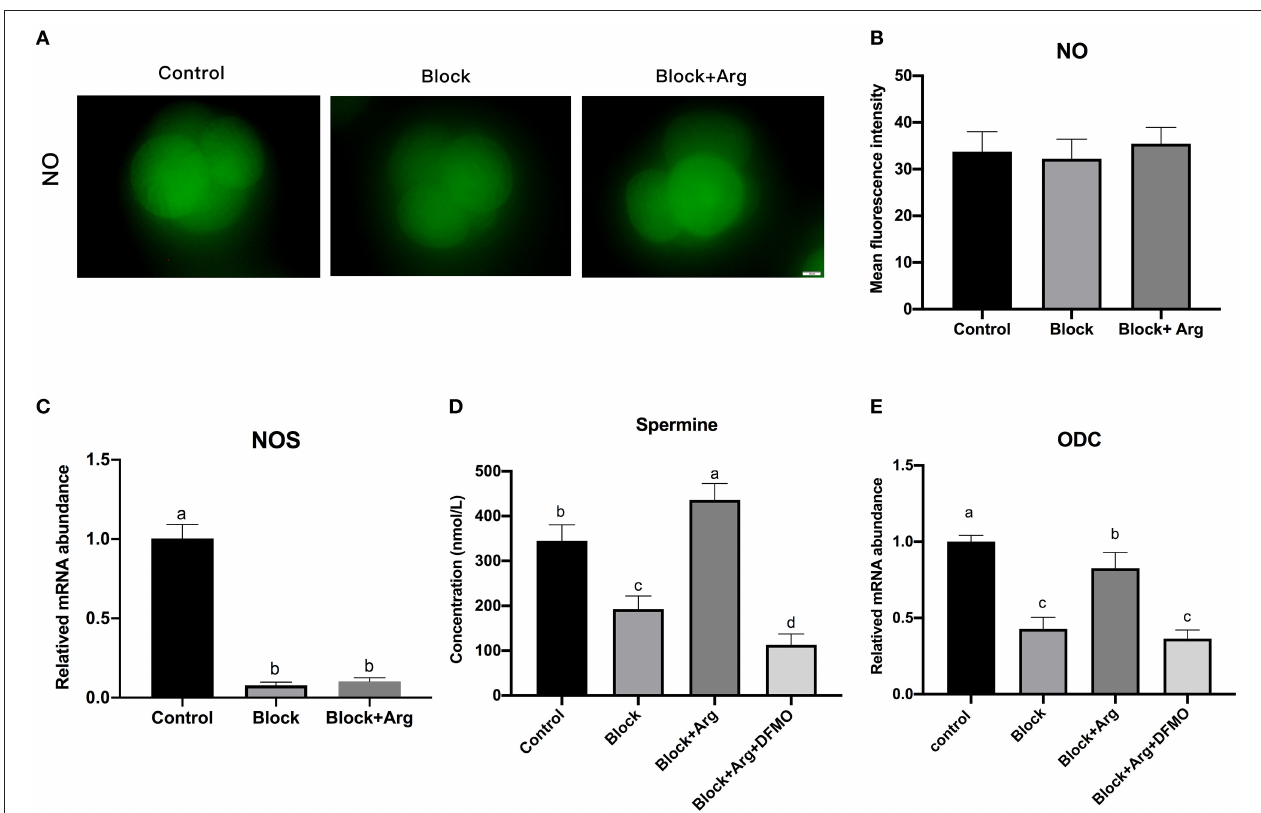
FIGURE 5 | Analysis of the arginine metabolic pathway during ZGA under nutrition restriction. (A) Representative images of DAF-FM fluorescence in the Control, Block and Block + Arg groups. Nitric oxide production viewed by using DAF-FM staining of 4-cell embryos. Bar = 50 µ m. (B) Results of the statistical analysis of embryonic NO intensity in the Control, Block and Block + Arg groups. Control: n = 30; Block: n = 30; Block + Arg: n = 30. (C) Expression of the NOS gene measured by qRT-PCR. NOS : nitric oxide synthase. (D) Results of the statistical analysis of spermine content in the culture medium at 48h after IVC in the Control, Block, Block + Arg and Block + Arg + DFMO groups. Control: n = 4; Block: n = 4; Block + Arg: n = 4; Block + Arg + DFMO: n = 4. (E) Expression of the ODC1 gene measured by qRT-PCR. ODC1 : ornithine decarboxylase 1. n = 3; different letters (a, b) indicate significant differences ( P =